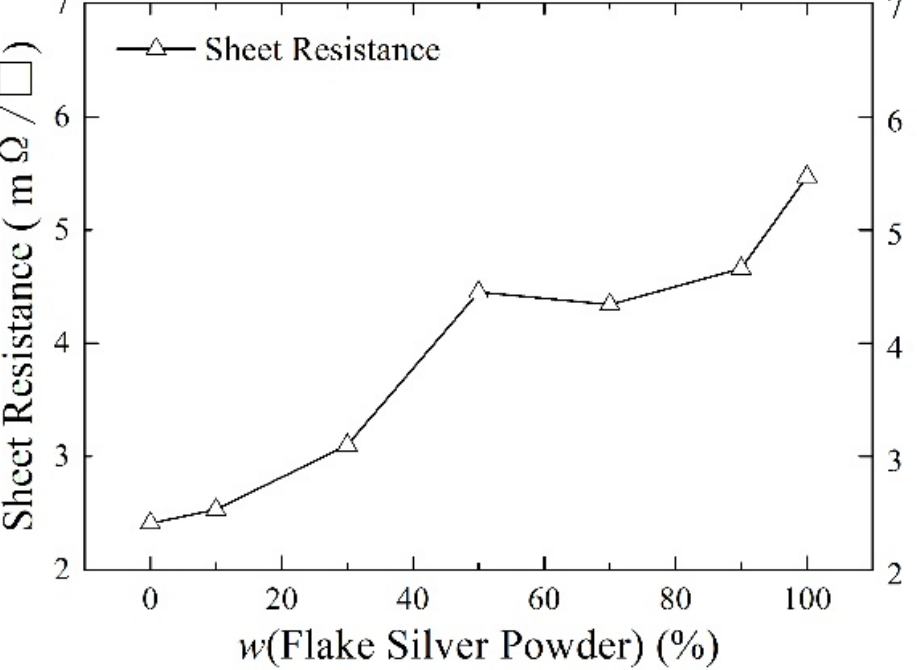
Figure 6. The effect of the flake silver powder content on the sheet resistance of the sintered silver film.